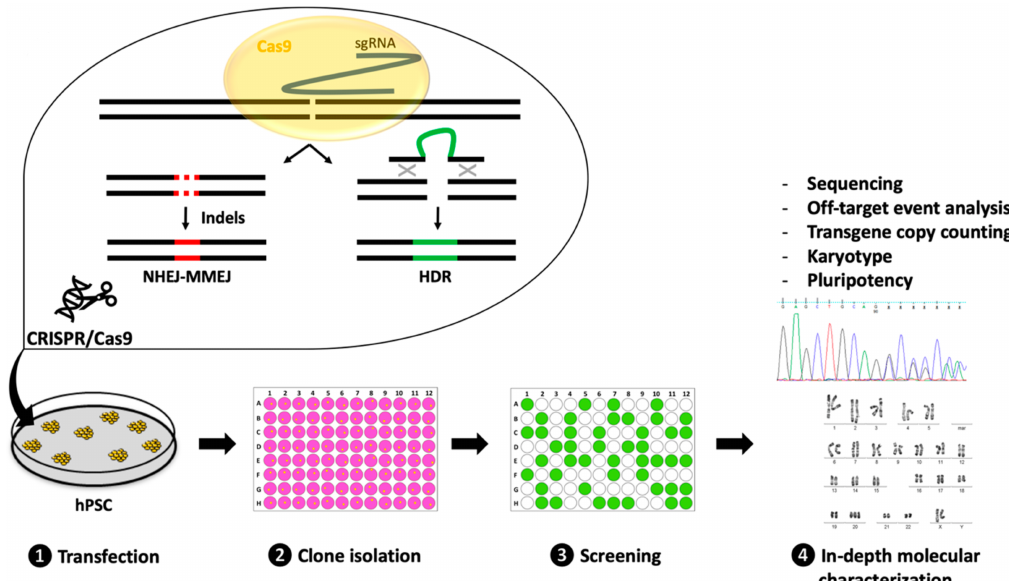
Figure 1. Pipeline to generate CRISPR-edited human pluripotent stem cell (hPSC) lines. Generating transgenic hPSC is a process that includes four mains phases: ( 1 ) Transfection of CRISPR reagents (single guide RNA, Cas9, and if required, a donor DNA template) in the parental hPSC line to introduce a targeted DNA double strand break (DSB). The DSB will be repaired by the endogenous DNA repair pathways. The non-homologous end-joining (NHEJ) and micro-homology-mediated end-joining (MMEJ) pathways can lead to the introduction of small insertions / deletions (indels), while the HDR pathway introduces exogenous nucleotides; ( 2 ) Transfected cells are isolated in separate wells to be expanded as clonal populations; ( 3 ) Following isolation, a high-throughput screening step is performed to select the correctly modified clones; ( 4 ) The selected clones are finally characterized using a combination of